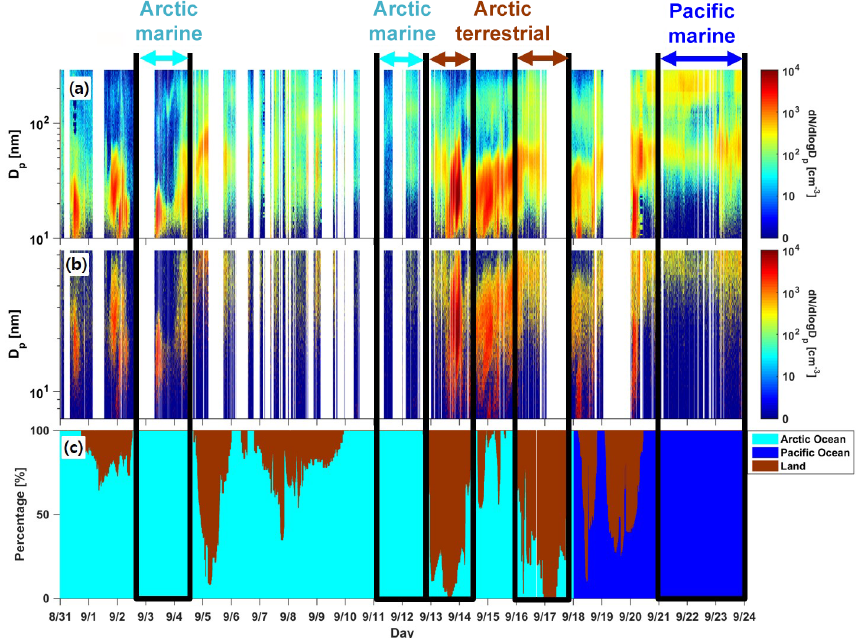
Figure 3. Contour plots of the size distributions measured using (a) standard and (b) nano-SMPS and (c) the residence time of air masses that passed over the Arctic Ocean, Pacific Ocean and land throughout the sampling periods.